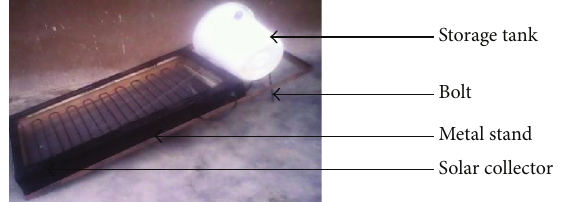
Table 10: Daily consumption of hot water in a Nigerian home.